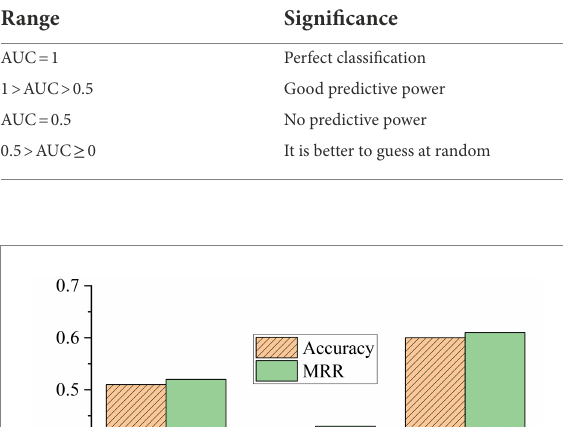
TABLE 2 Metrics for AUC.